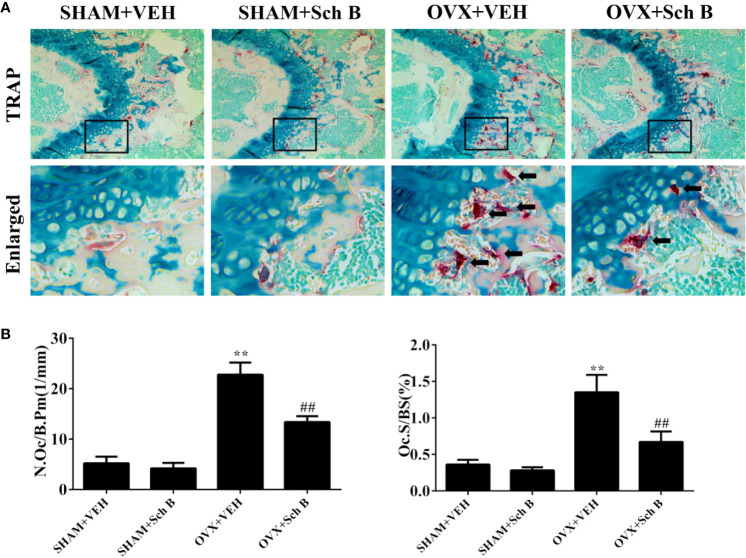
Schisandrin B reduces osteoclast formation in an ovariectomized murine model. (A) TRAP staining results of representative sections of distal femurs in the indicated four groups. (B) Bone histomorphometric analyses for number of osteoclasts per bone perimeter (N.Oc/B.Pm) and osteoclast surface per bone surface (Oc.S/BS). Data are presented as means ± SD. **P < 0.01 versus the SHAM+VEH group. ##P < 0.01 versus the OVX+VEH group.